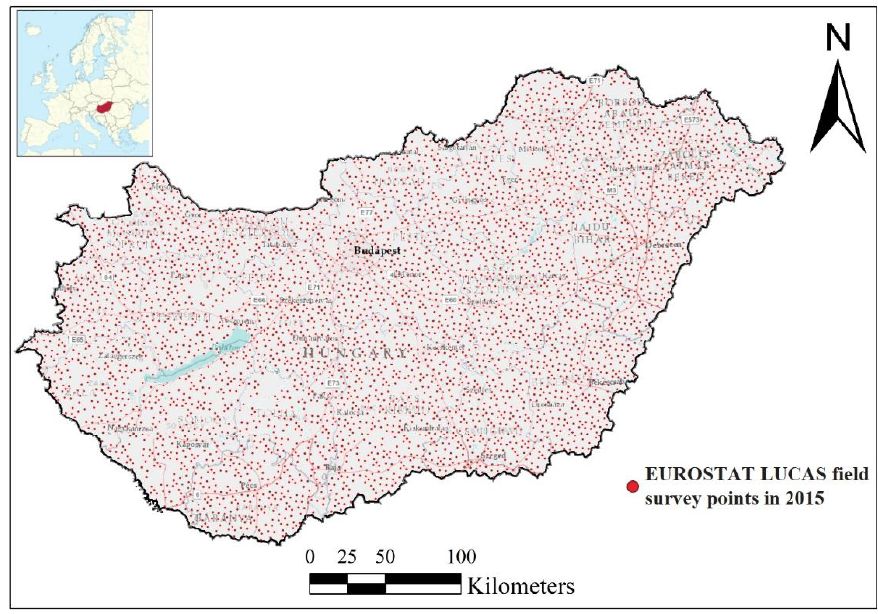
Figure 1. The LUCAS field survey points of Hungary in 2015.